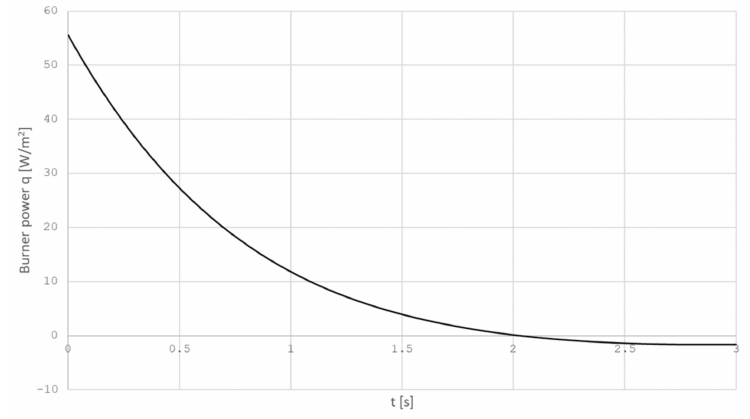
Figure 7. The heat source power dependence q max on time t